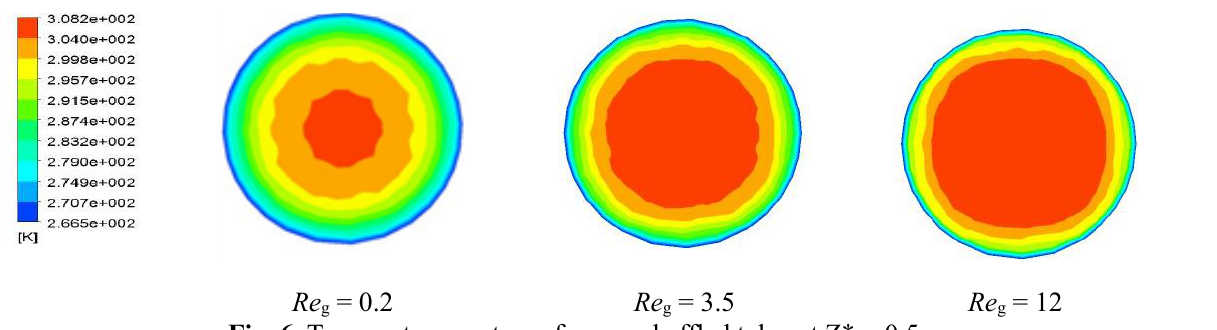
Fig. 6. Temperature contours for an unbaffled tube, at Z* =